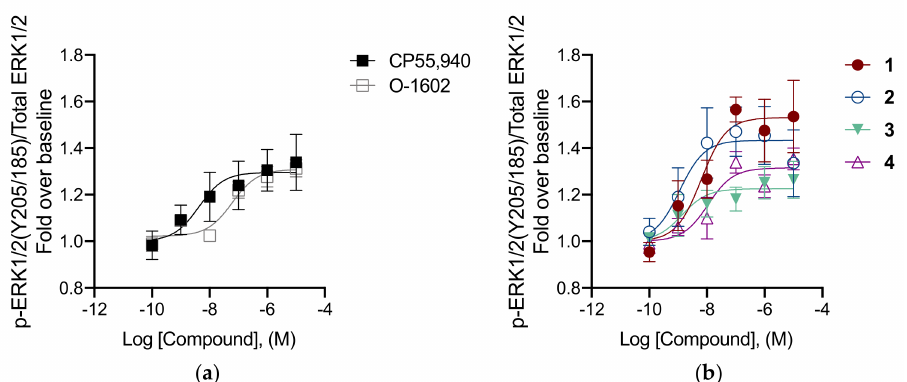
Figure 5. In vitro characterization of p-ERK1/2 in the presence of reference compounds CP55,940 and O-1602 ( a ) and of compounds 1 – 4 ( b ) at h GPR55. CHO cells expressing h GPR55 were treated with 0.1–10 µ M compounds for 30 min. Data are expressed as fold over vehicle and are means ± SEM ( n = 6 independent experiments performed in duplicate). All data were fit to a 3-parameter non-linear regression in GraphPad (v. 9.0). Analyses are presented in Table